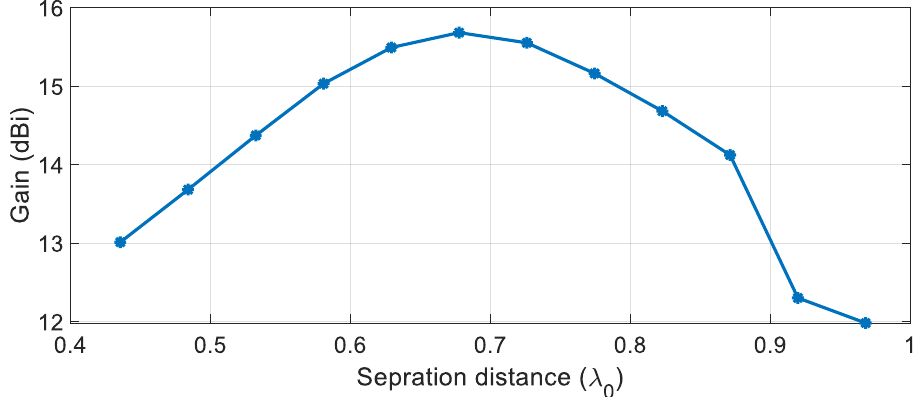
Figure 12. The gain profile variation for different inter-element spacing.